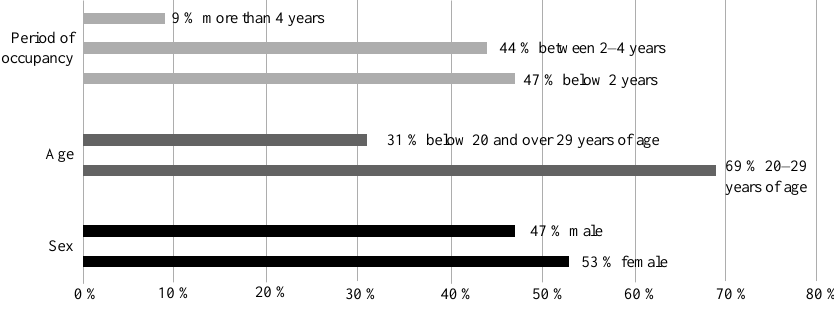
Fig. 11. Demographic characteristic of the